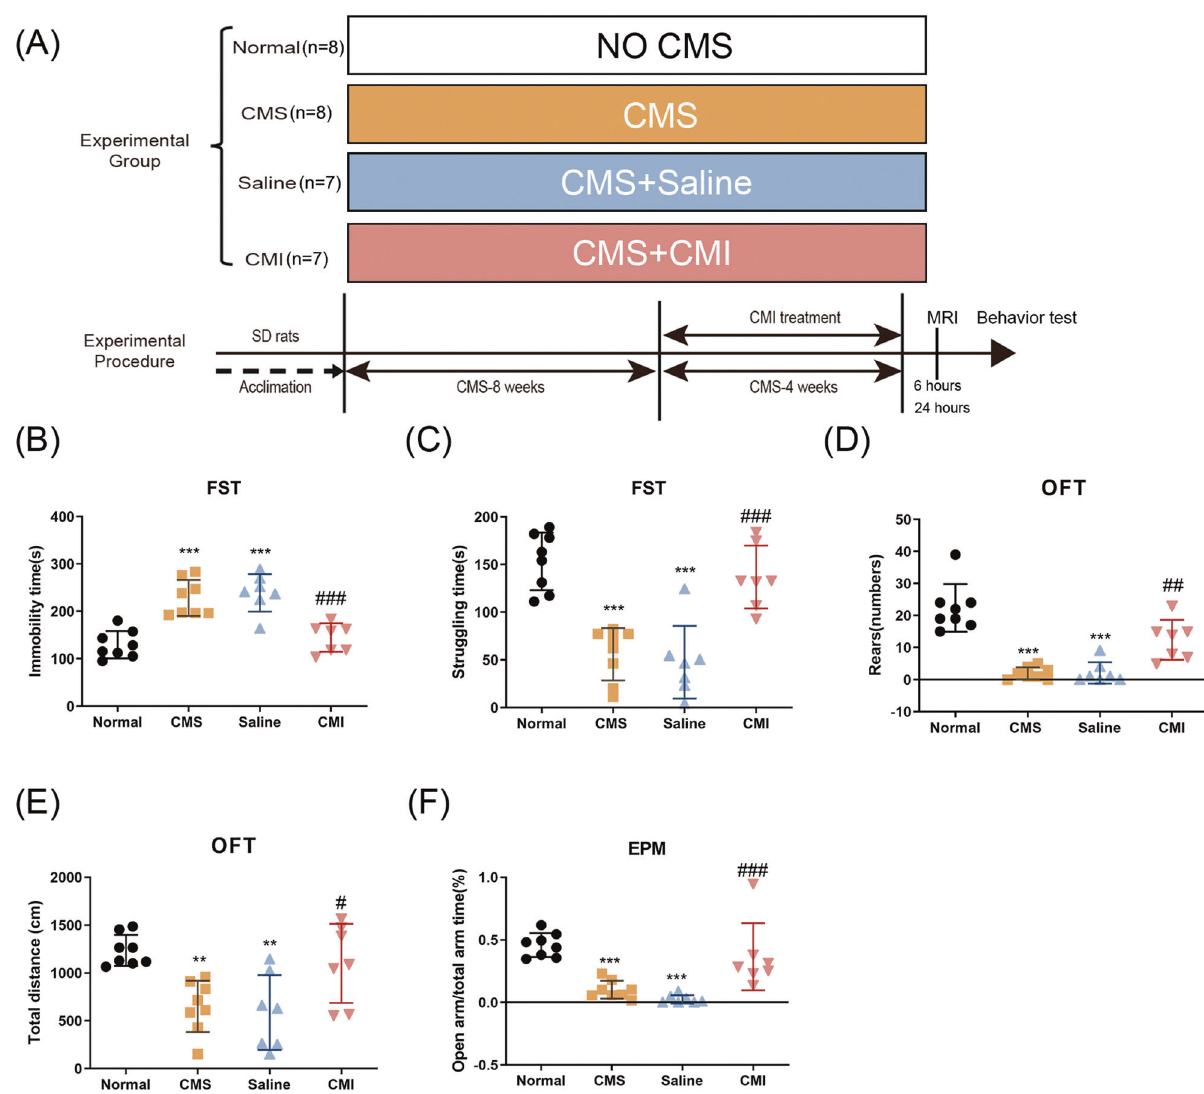
Fig. 1 Chronic clomipramine treatment reversed CMS-induced depressive- and anxiety-like behaviors. A Schematic diagram of our experimental design. B Immobility time and C struggling time in the FST. D Rearing numbers and E total distance traveled in the OFT. F Percentage of open-arm time in the EPM test ( n = 7 – 8/group). All data are expressed as the mean ± SD. # p < 0.05, ## p < 0.01, ### p < 0.001 compared to saline-treated rats. ** p < 0.01, *** p < 0.001 compared to non-stressed control